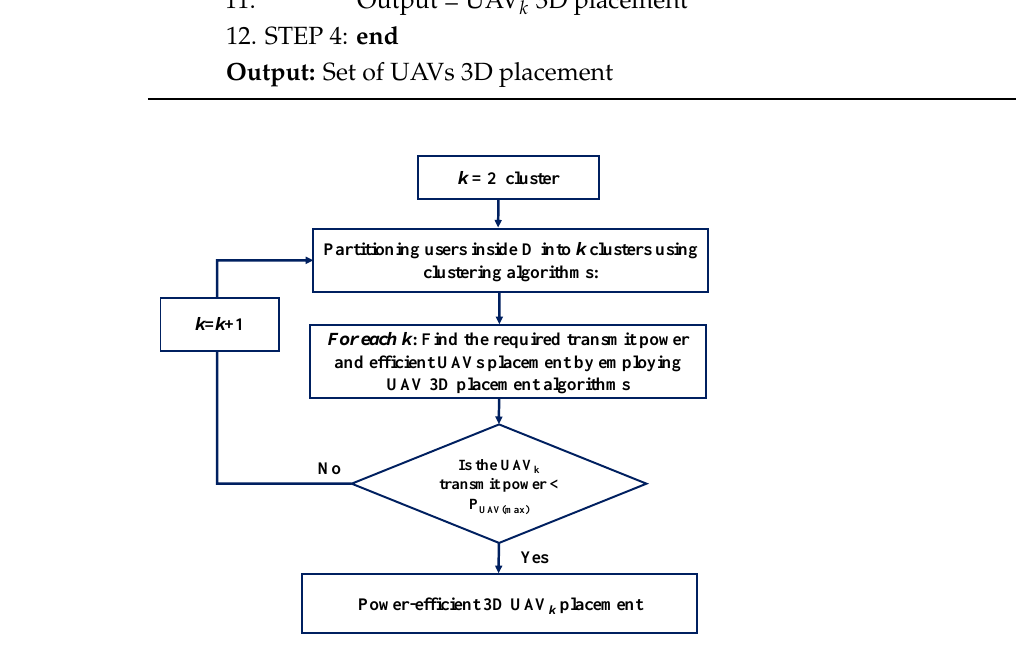
Figure 2. Flowchart of the proposed heuristic